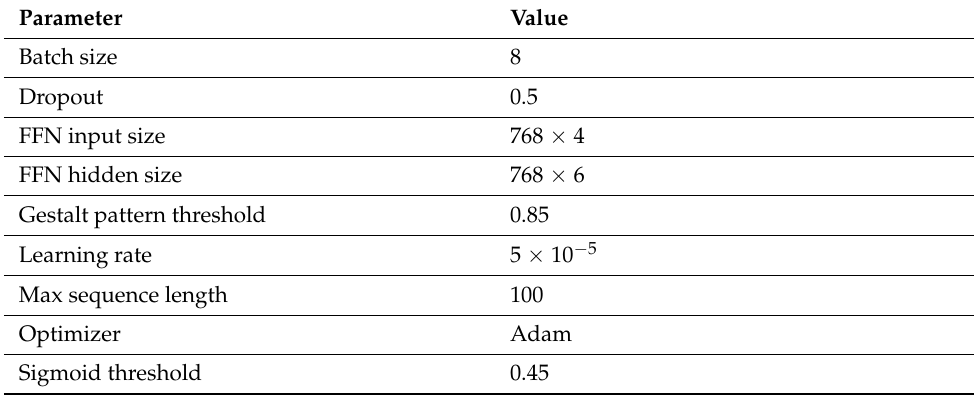
Table 2. Major hyperparameters in our